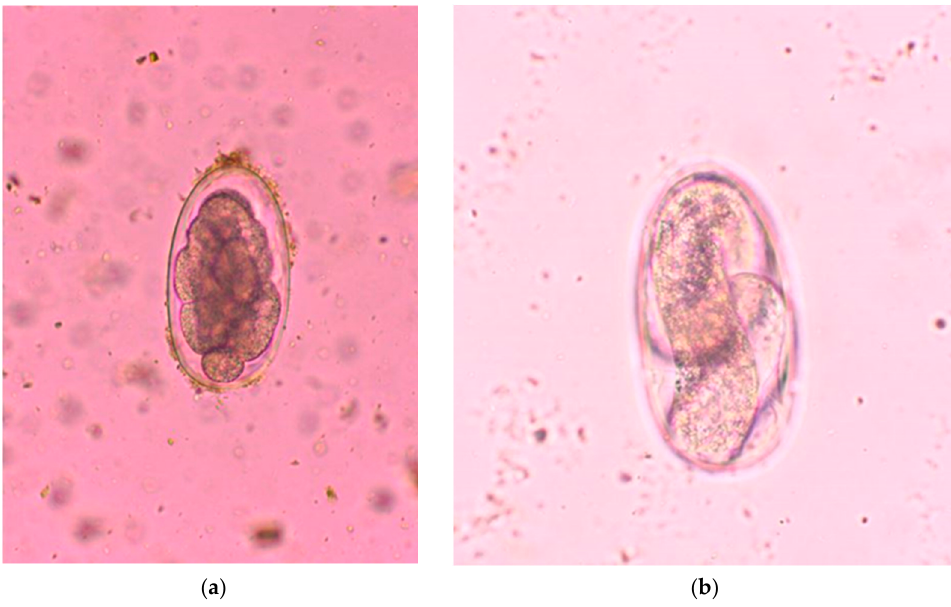
Figure 2. Eggs detected in fecal samples: ( a ) Strongylidae; ( b ) Strongyloididae; not to scale.